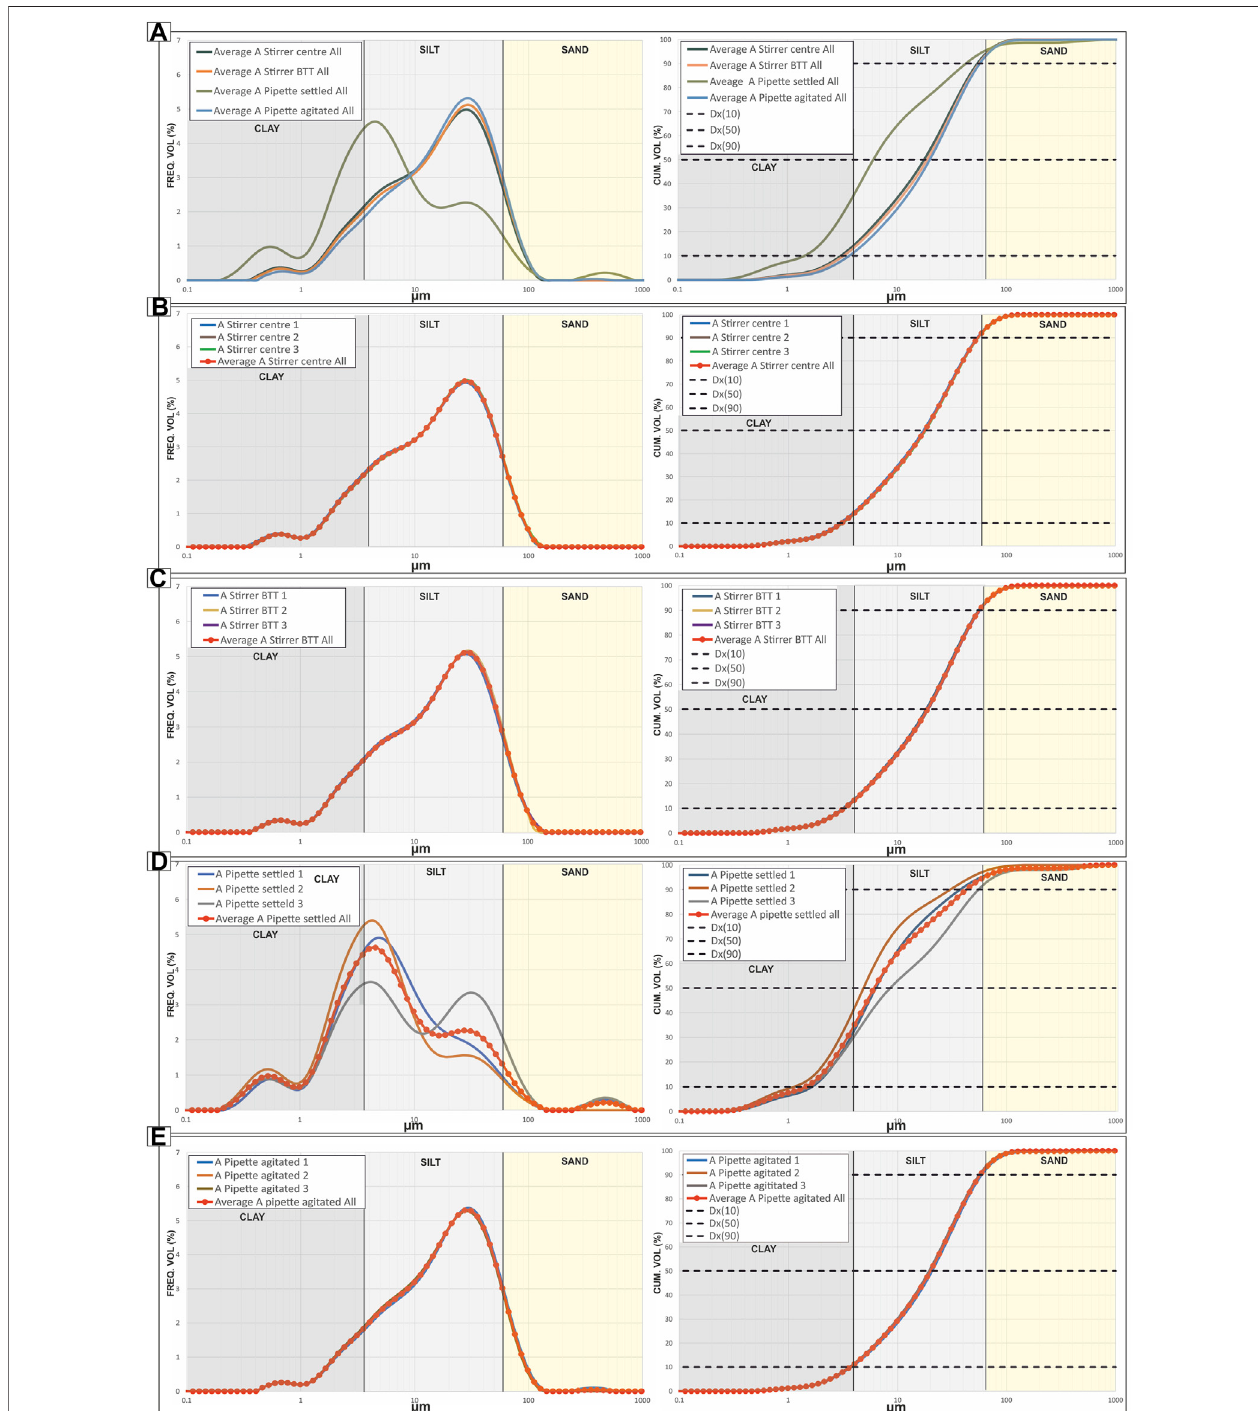
FIGURE 6 | Volume frequency and cumulative frequency of aliquots for mud-rich fi eld sample V B209 S22 using various trial methods. See text for full details. (A) Averageresultsforalltrialmethodsforcomparison. (B) Individualresultsandaverageforthe ‘ Stirrercentre ’ method. (C) individualresultsandaveragefor “ Stirrerbaseto top ” method. (D) Individualresultsandaveragefor ‘ Pipettesettled ’ method. (E) Individualresultsandaveragefor ‘ Pipetteagitatedmethod ’ .Forfulldata Supplementary Table S1 , for corresponding p -values Supplementary Table S2 .